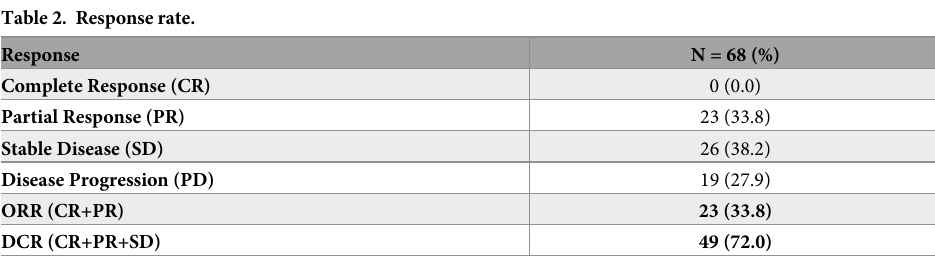
Table 2. Response